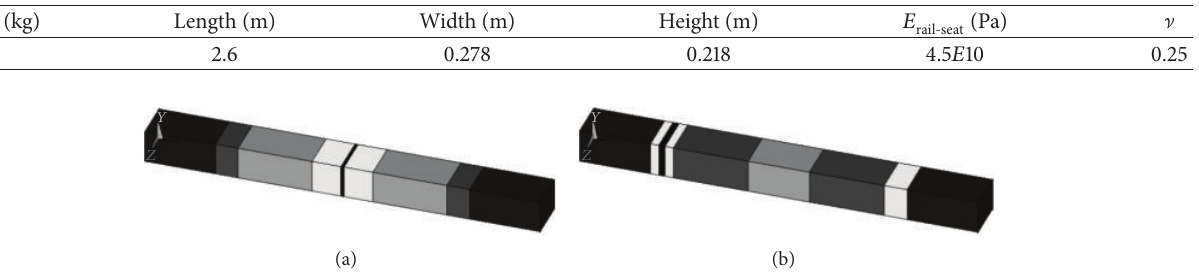
Table 1: Uncracked sleeper model properties.